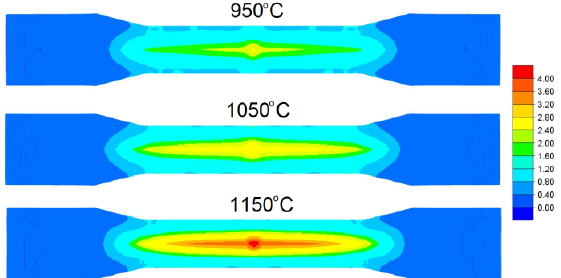
Figure 5. Distribution of the normalised Cockcroft–Latham damage criterion for different temper ‐